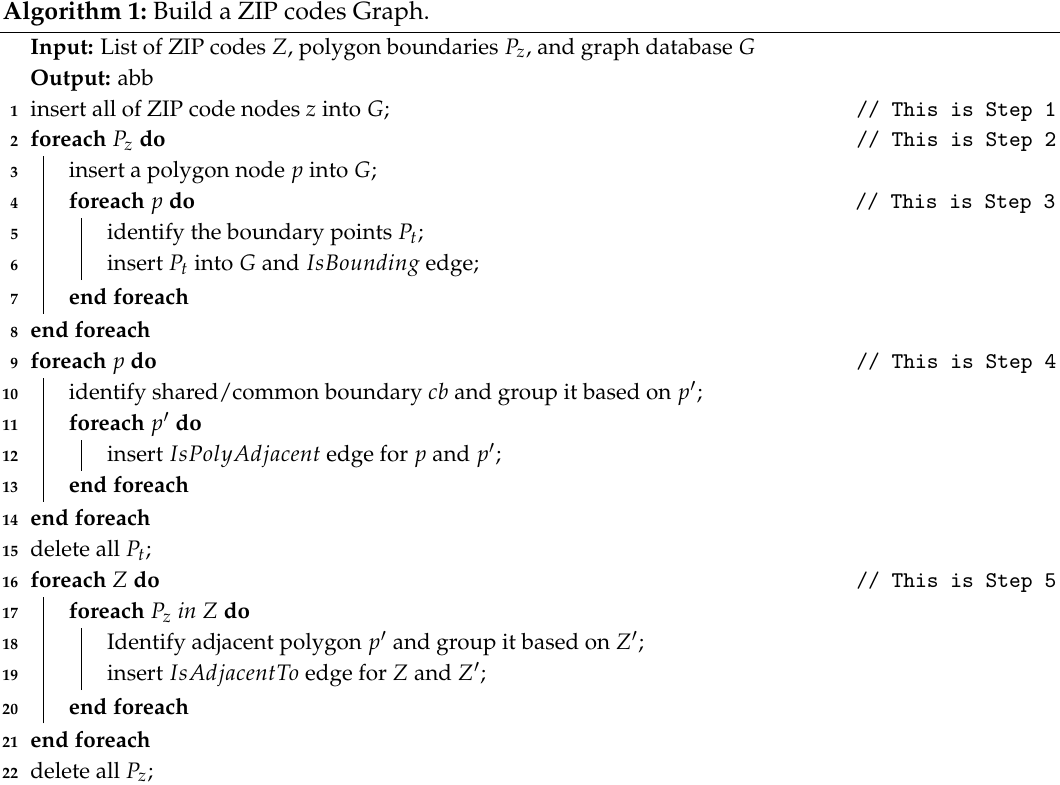
Algorithm 1: Build a ZIP codes